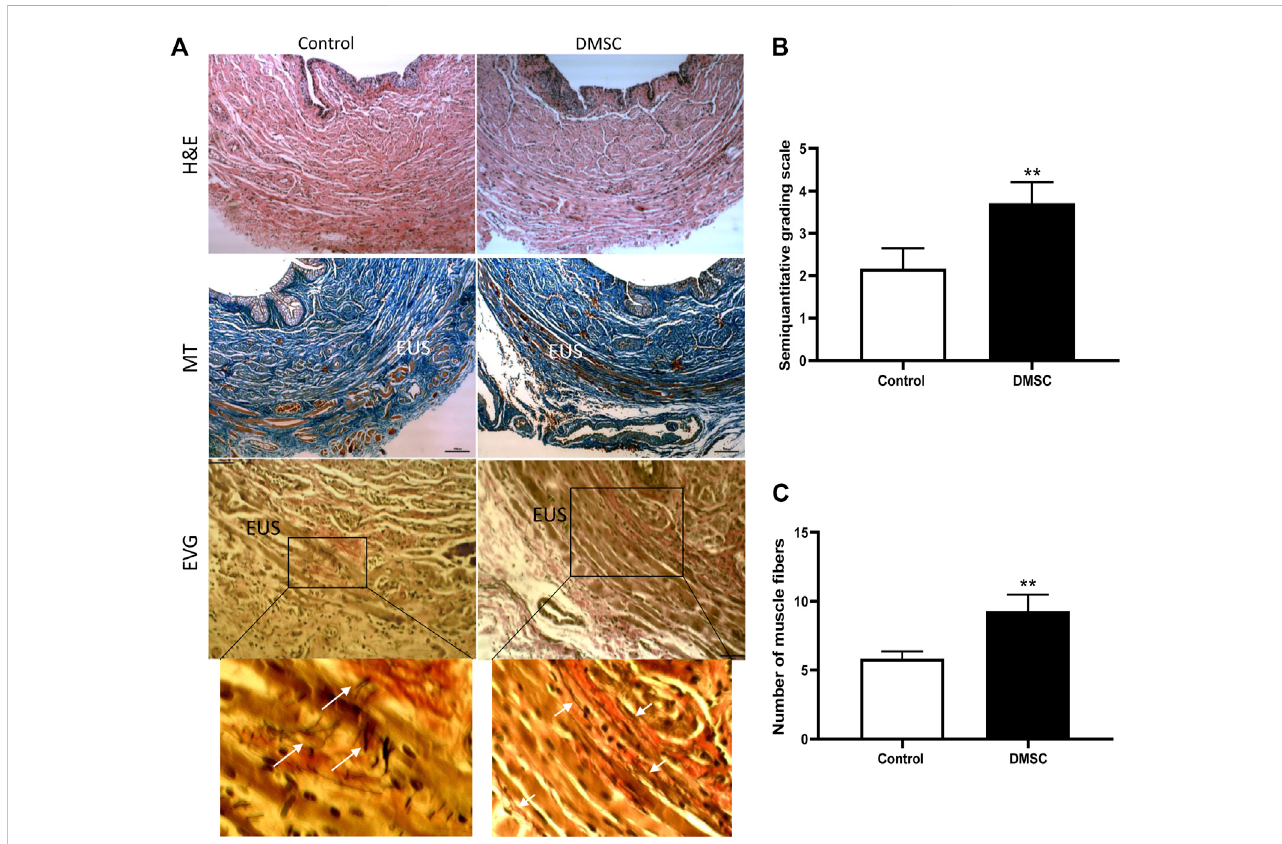
FIGURE 2 Periurethral injection of DMSC reverses VD-induced muscle and connective tissue disruption in the urethra. (A) Histological staining of urethral sections after VD and DMSC or HBSS (Control) treatment. Examples of urethral cross-sections stained with haematoxylin/eosin (H&E; upper panels), Masson´s trichrome (MT; middle panels) or elastin von Giesson (EVG; lower panels) 6 weeks after VD. EUS: external urethral sphincter. Inset in EVG panels is shown in highermagni fi cationinthepanelsplacedjustbelow.Scalebar:100 μ m.Whitearrowsindicatedisorganizedelastin fi bersinControl-EVGexampleswhile elastin fi bers in DMSC-EGV examples are more organized. (B) Semi-quantitative analysis of Masson ’ s-trichrome-staining using a grading scale showing that the urethra of rats in the DMSC-treated group appeared to have more complete muscle fi bers in the EUS than those in the control group. (C) Analysis of total numberofmuscle fi bersinEUSinDMSC-treatedandincontrolanimalsshowedsigni fi cantdifferencesbetweenthetwogroups.DataofBandCareshownas mean ± standard deviation (SD) and correspond to the comparison of DMSC-treated vs. control animals. ** p <